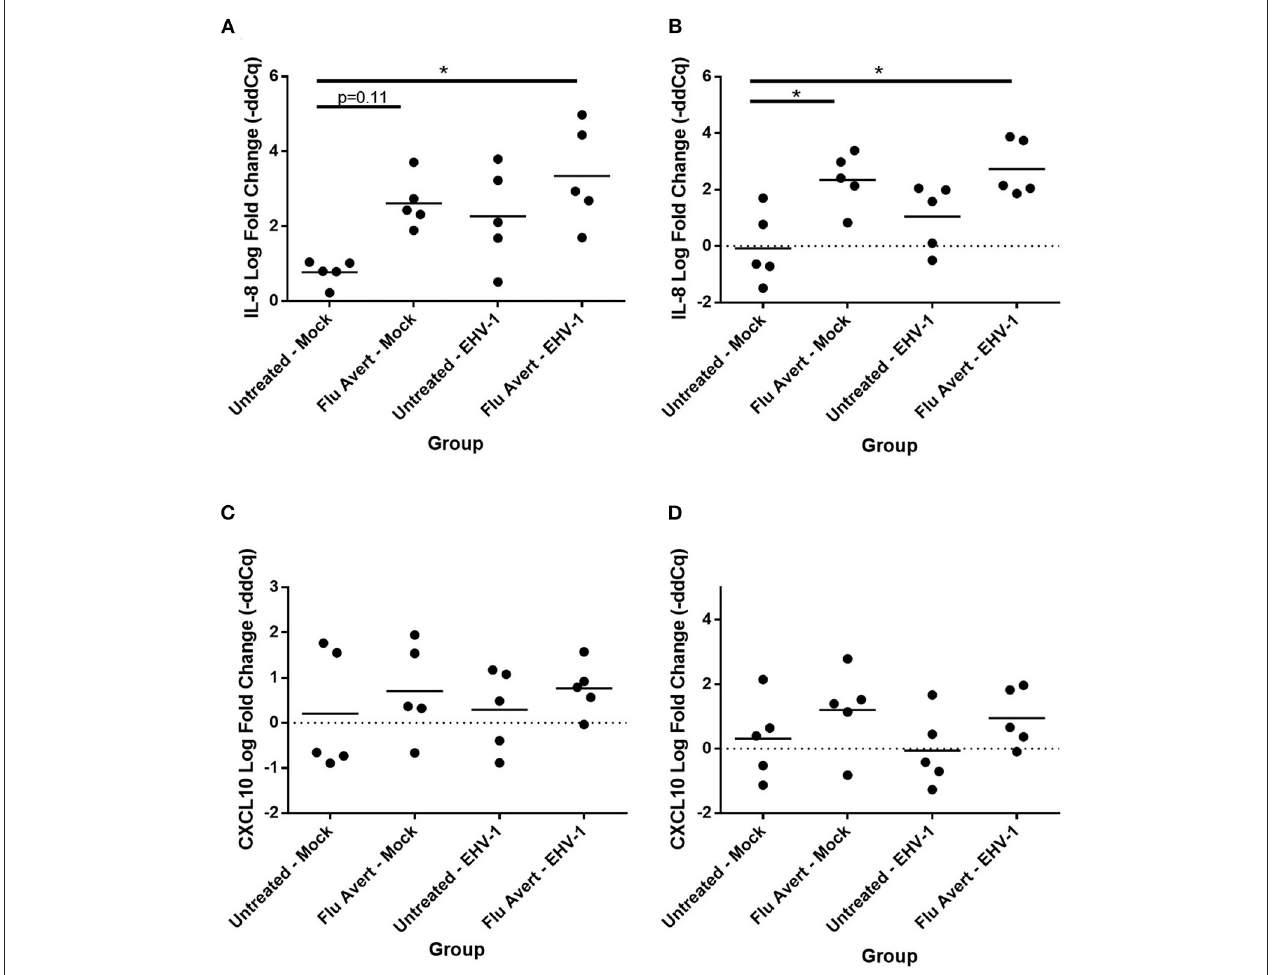
FIGURE 4 | Effect of Flu Avert treatment on chemokine mRNA expression in ERECs collected from five horses 24h following EHV-1 inoculation. (A) IL-8 mRNA expression in ERECs that were treated with Flu Avert on day 5 prior to EHV-1 inoculation. (B) IL-8 mRNA expression in ERECs that were treated with Flu Avert on day 7 prior to EHV-1 inoculation. (C) CXCL10 mRNA expression in ERECs that were treated with Flu Avert on day 5 prior to EHV-1 inoculation. (D) CXCL10 mRNA expression in ERECs that were treated with Flu Avert on day 7 prior to EHV-1 inoculation. The mean log fold change (–ddCq) is represented by a bar (* p <